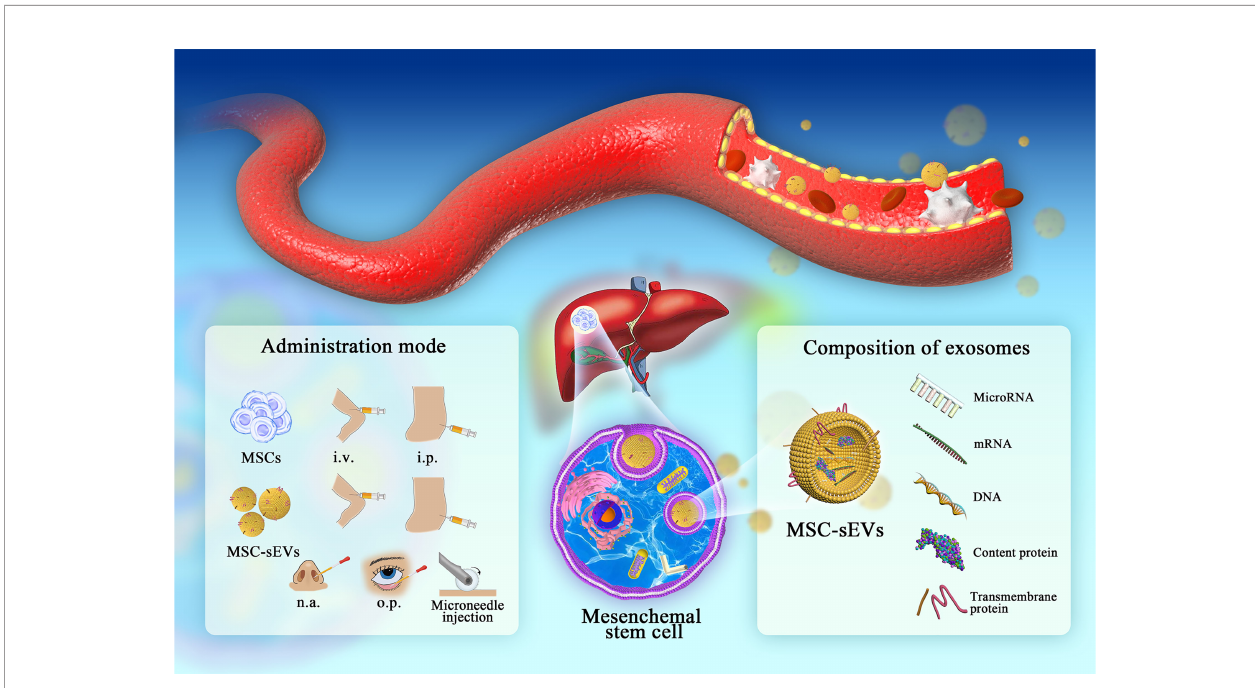
FIGURE 1 | The administration of MSCs/MEC-sEVs and detailed composition of MSC-sEVs (i.v., intravenous injection; i.p., intraperitoneal injection; n.a., nasal drip; o.p., eye drop.). In liver diseases, MSC colonization and sEV circulation play important roles in damage repair. Research on the composition and administration of sEVs provides a novel chance for follow-up clinical